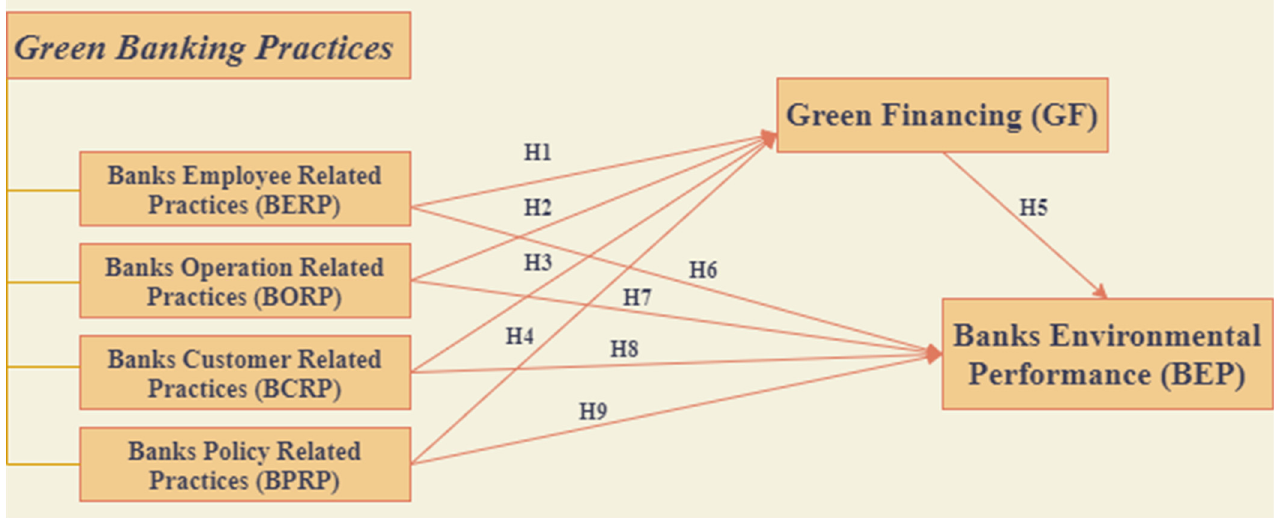
Figure 2. Conceptual framework of the